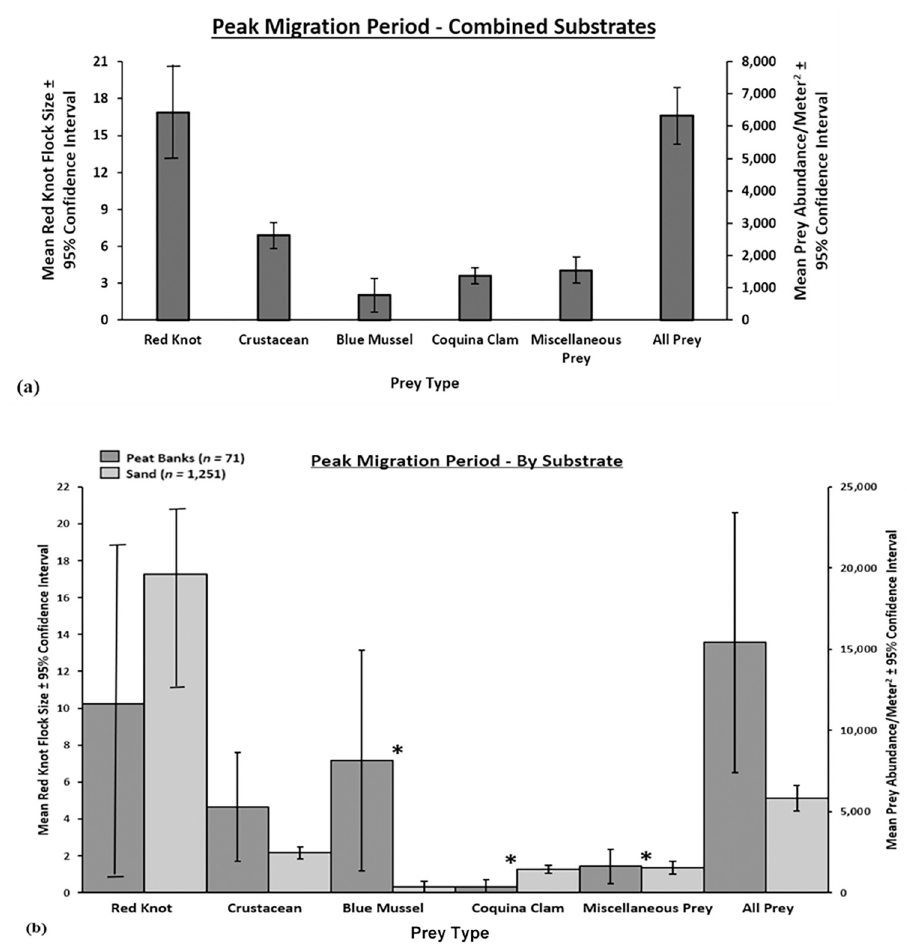
Fig 4. Red knot flock size and mean prey abundance for combined substrates and individually by peat bank and sand substrate for samples collected during red knot peak migration (21–27 May). Mean red knot flock size per 100 m radius semicircle on the water line and mean abundance (organisms/m 2 ± 95% CI) of crustaceans, blue mussels, coquina clams, miscellaneous prey, and all prey captured in 10 cm diameter x 3.5 cm deep cores on (a) peat and sand substrates combined ( n = 1,322) and on (b) peat banks ( n = 71) and sand ( n = 1,251) separately at the approximate peak of red knot migration (‘peak migration period’), May 21–27, 2007–2018, Virginia’s barrier islands. � Indicates a difference (p < 0.05) in red knot flock size and prey abundances between peat and sand substrates based on Wilcoxon rank sum tests with Bonferroni correction. Note: y-axis scales differ between (a) and (b). red knots decrease energy expenditure and maximize foraging efficiency by foraging in loca- tions that are most profitable (i.e., those that provide the highest abundance of prey in the shortest period [41,89]). Prior work in other systems has also consistently demonstrated that red knots likely feed on prey that are most digestible [90–94]. For example, in the Dutch Wad- den Sea site, which closely resembles the intertidal habitat of Virginia’s barrier islands, red knots selected juvenile edible cockles ( Cerastoderma edule ) that had thinner shells and propor- tionately high flesh content to maximize energy intake rates and reduce processing time (i.e., shell digestion [95,96]). Other studies have also demonstrated that shorebirds such as sander- ling ( Calidris alba ), Eurasian oystercatchers ( Haematopus ostralegus ), and dunlin ( Calidris alpina ) select prey that maximize their caloric intake [97–99]. Additional study into the energy content and digestibility of all prey available to red knots in Virginia would help further clarify the relationship among red knots, prey, and habitat selection.